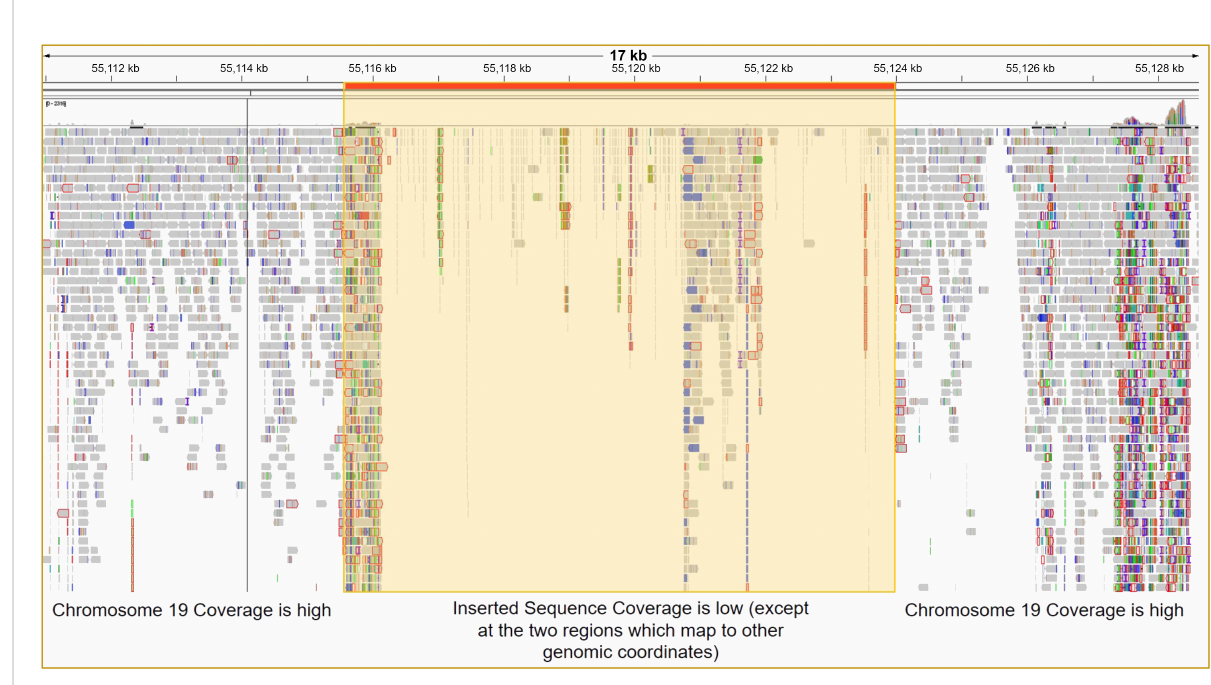
FIGURE 8 Whole genome sequencing (WGS) of PLCs to determine whether CRISPR/Cas9 editing led to successful insertion of the EF1 a -lcoET3 expression cassette at the AAVS1 genomic locus. After ensuring DNA integrity, WGS was performed with 40X coverage using the DNBSEQ ™ NGS platform, and the sequence reads were aligned to a standard reference human genome containing the inserted sequence at the desired